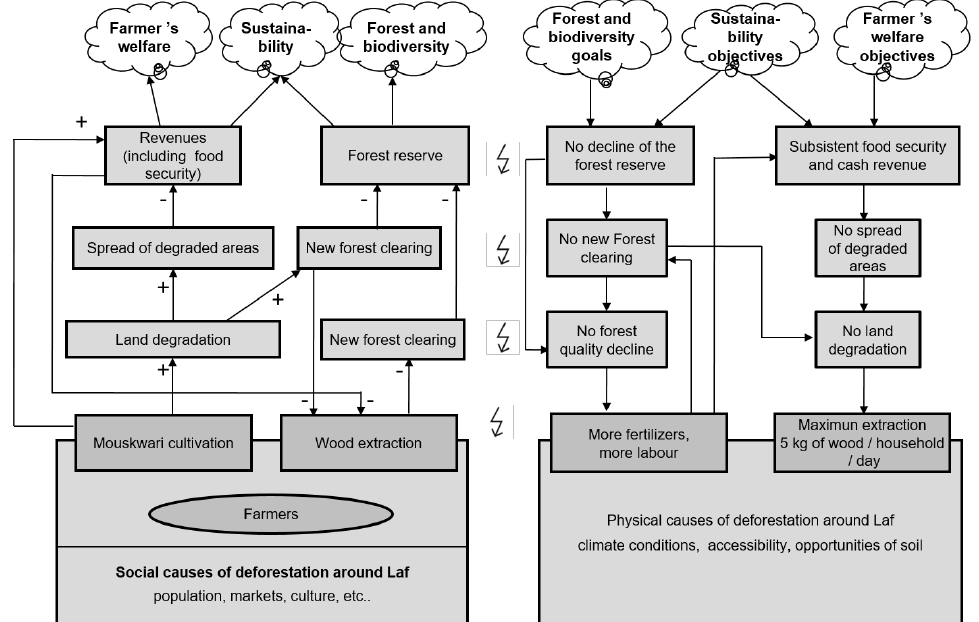
Figure 8. Analysis of the environmental problem in the Laf Forest Reserve [72]. Left and right are facts and norms, respectively. Factual causal chains run primarily up towards the final variables (farmers’ welfare etc.). In bold are the most important output variables of the model. The pluses indicate positive relations (more of A, then more of B); the minuses indicate the